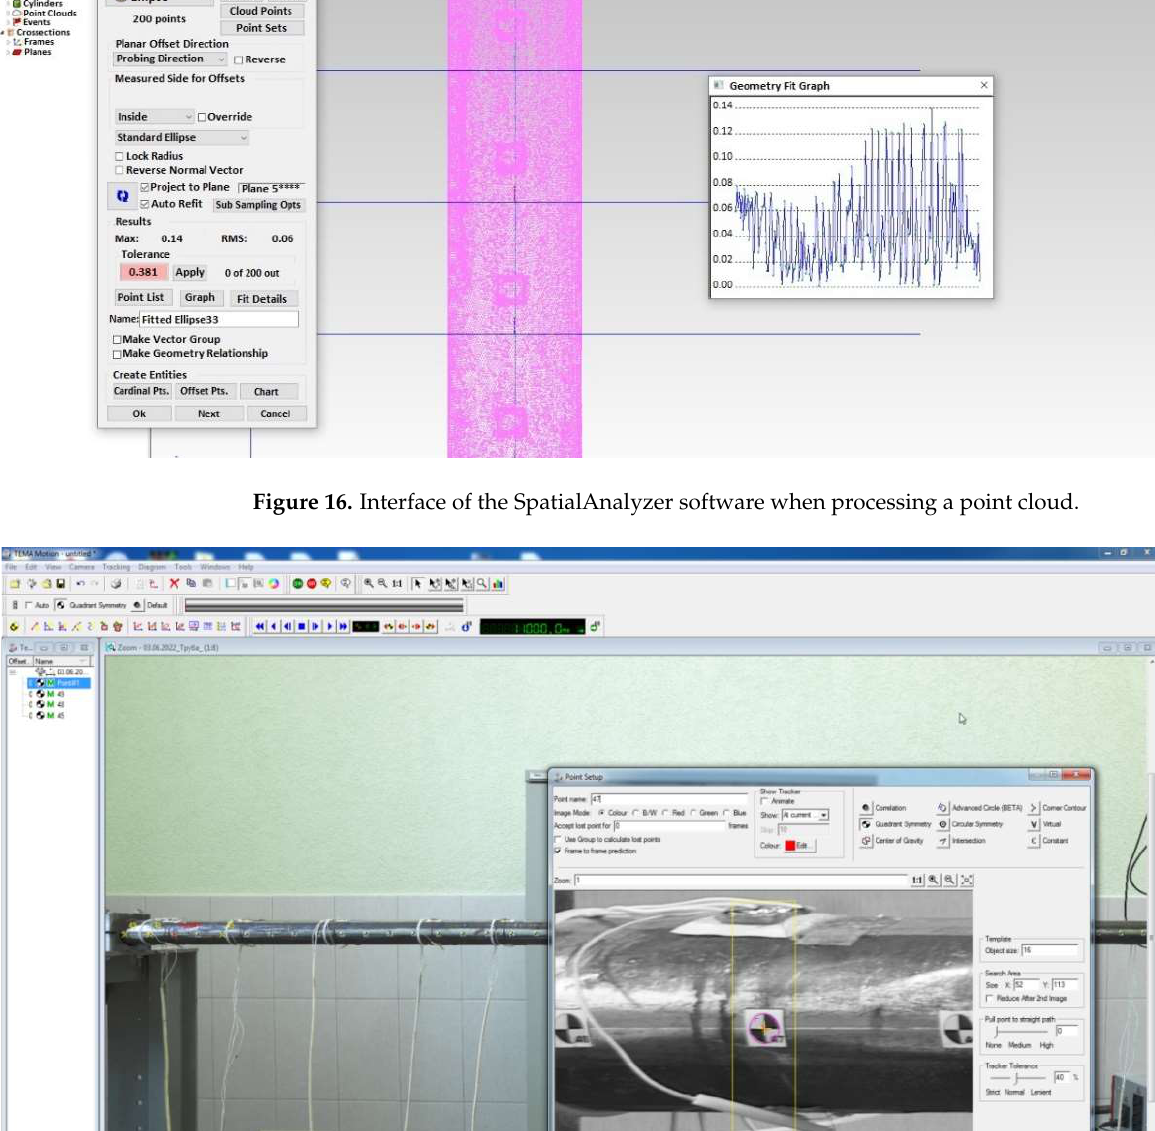
Figure 16. Interface of the SpatialAnalyzer software when processing a point cloud.